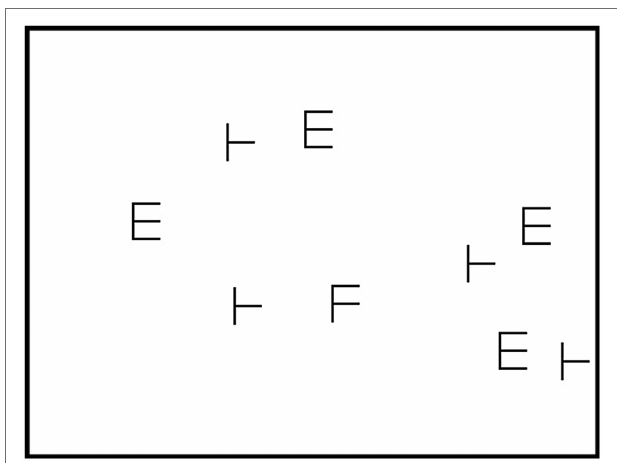
FIGURE 2 | Screenshot of a medium-sized set of stimuli in the visual search